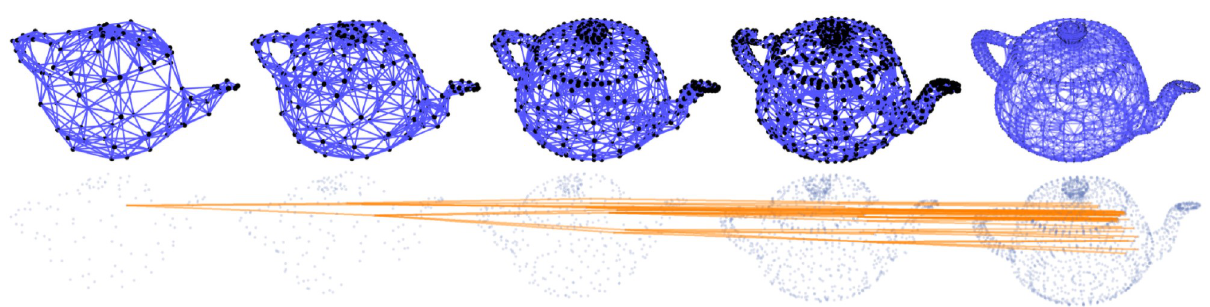
Fig 2. Top: subsamples of a mesh of the Utah teapot, of increasing density (each node is connected to its 8 nearest neighbors by the Δ l = ± 0 edges, rendered in blue). These samples form a graph lineage ( Δ l = ± 1 edges are not illustrated). Bottom: the same set of nodes, with only Δ l = ± 1 edges plotted (in orange) for one node from the coarsest level and its